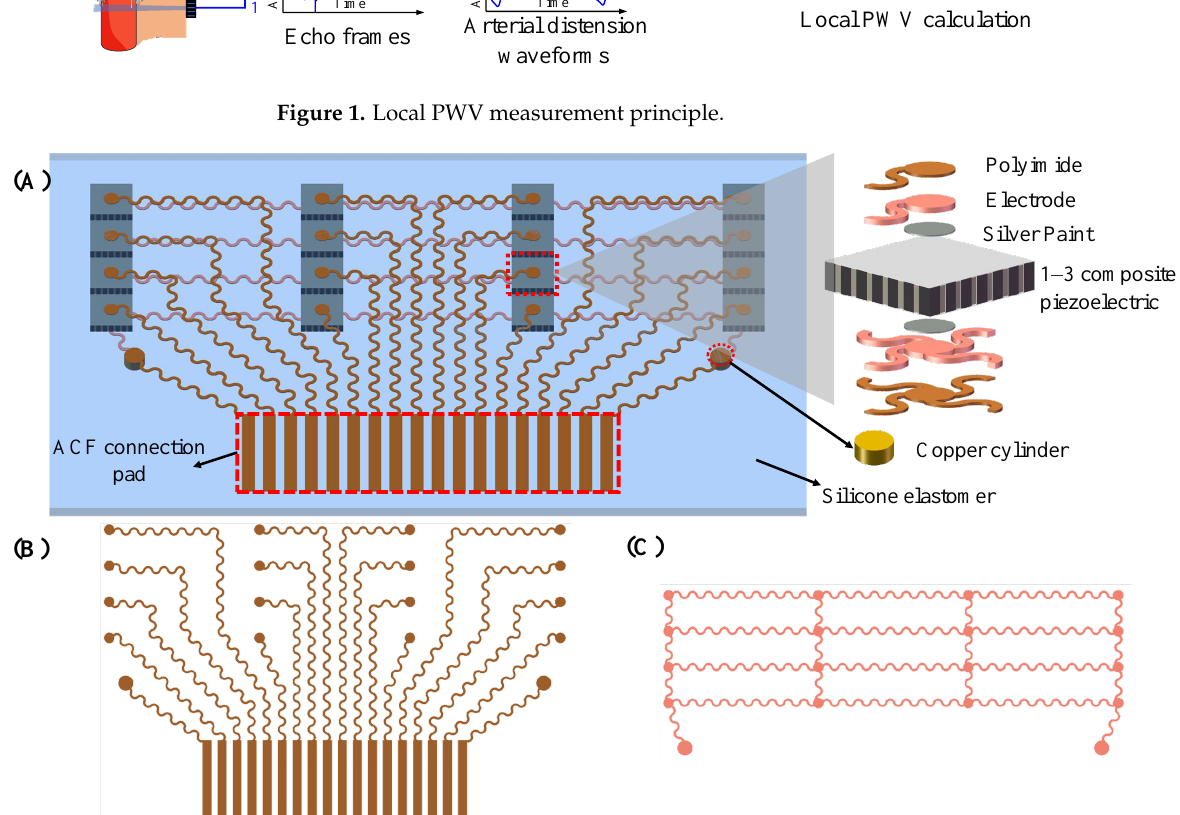
Figure 2. Flexible ultrasound array design and working principle. ( A ) Schematic (left) and exploded view (right) of the device structure. ( B ) Top electrode (polyimide side). ( C ) Bottom electrode (Cu